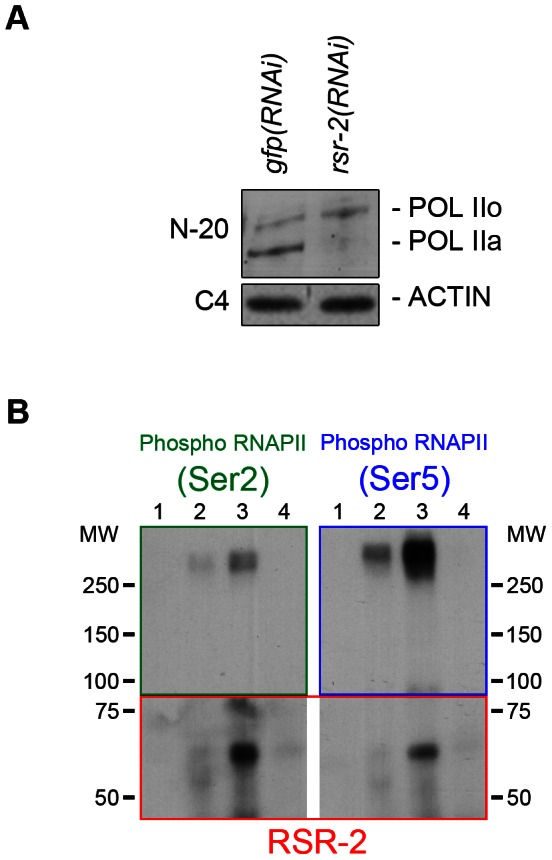
RSR-2 interacts with RNAPII and affects its phosphorylation state.RNAPII phosphoisoform detection by western blot in wild type and rsr-2(RNAi) worms. POL IIo is the abbreviation for the hyperphosphorylated form of the RNAPII whereas POL IIa represents the hypophosphorylated form of the RNAPII. Hyperphosphorylated RNAPII accumulates in rsr-2(RNAi) worms. The actin antibody C4 was used as a loading control. (A) RNAPII phosphoisoforms detected with the N-20 antibody. (B) RNAPII phosphoisoforms co-immunoprecipitate with RSR-2. IP was performed with the anti-RSR-2 antibody using an extract from a mixed-stage worm population. Eluted IP product was checked for the presence of RNAPII phosphorylated isoforms (Ser-2 and Ser-5 phosphorylation). Lane 1: Input (4% of IP), lane 2: IP with unspecific rabbit IgG antibody, lane 3: IP with RSR-2 antibody, lane 4: unspecific binding to beads. Pictures displayed are representative of a series of two experiments.